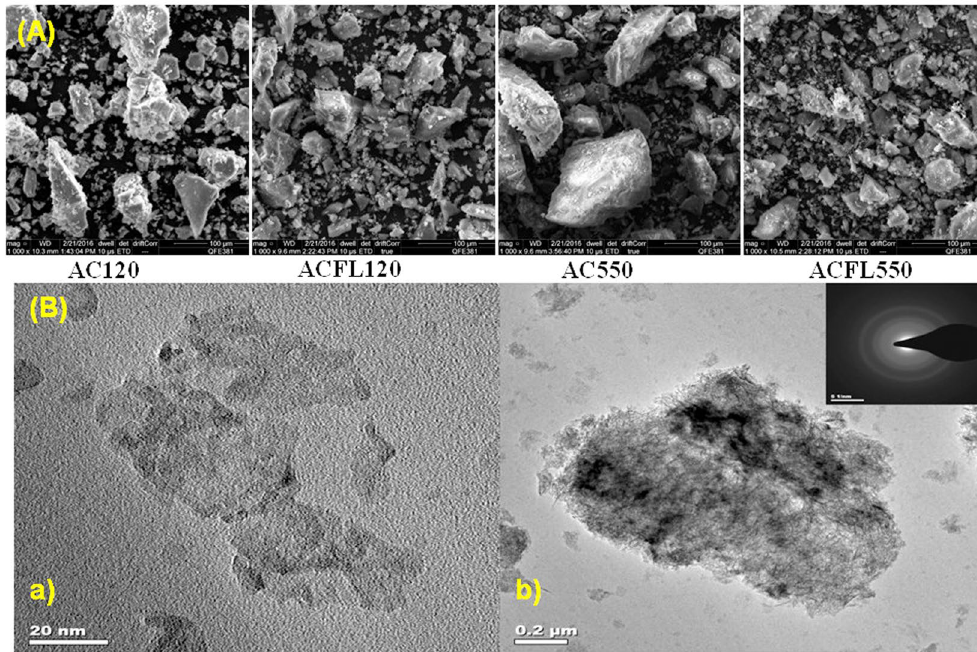
Figure 3. ( A ) SEM images of boehmite ( γ -AlOOH) produced from commercial aluminium chloride (AC120) and aluminium foil waste (ACFL120) along with the γ -Al 2 O 3 produced from commercial aluminium chloride (AC550) and aluminium foil waste (ACFL550). ( B ) (a) TEM overview image of the TEM-BF, (b) the acquired area of SAED pattern of the un-purified ACFL550 ( γ -Al 2 O 3 prepared from Al foil) with SAED